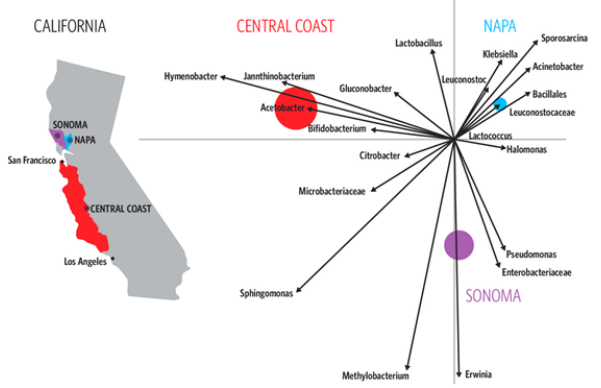
Figure 1. Differences in grape surface microbial communi- ties present between wine regions of California. From https://